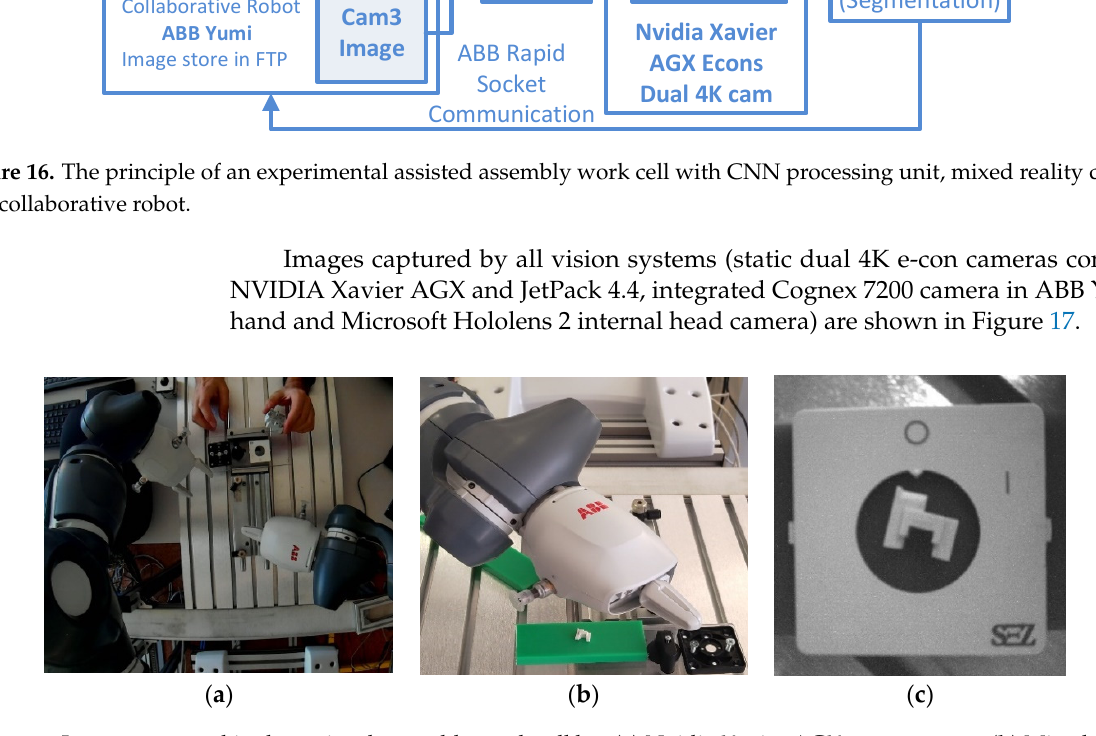
Figure 17. Images captured in the assisted assembly work cell by: ( a ) Nvidia Xavier AGX e-con camera; ( b ) Mixed reality Microsoft Hololens 2 head camera; ( c ) ABB Yumi Cognex Vision system.